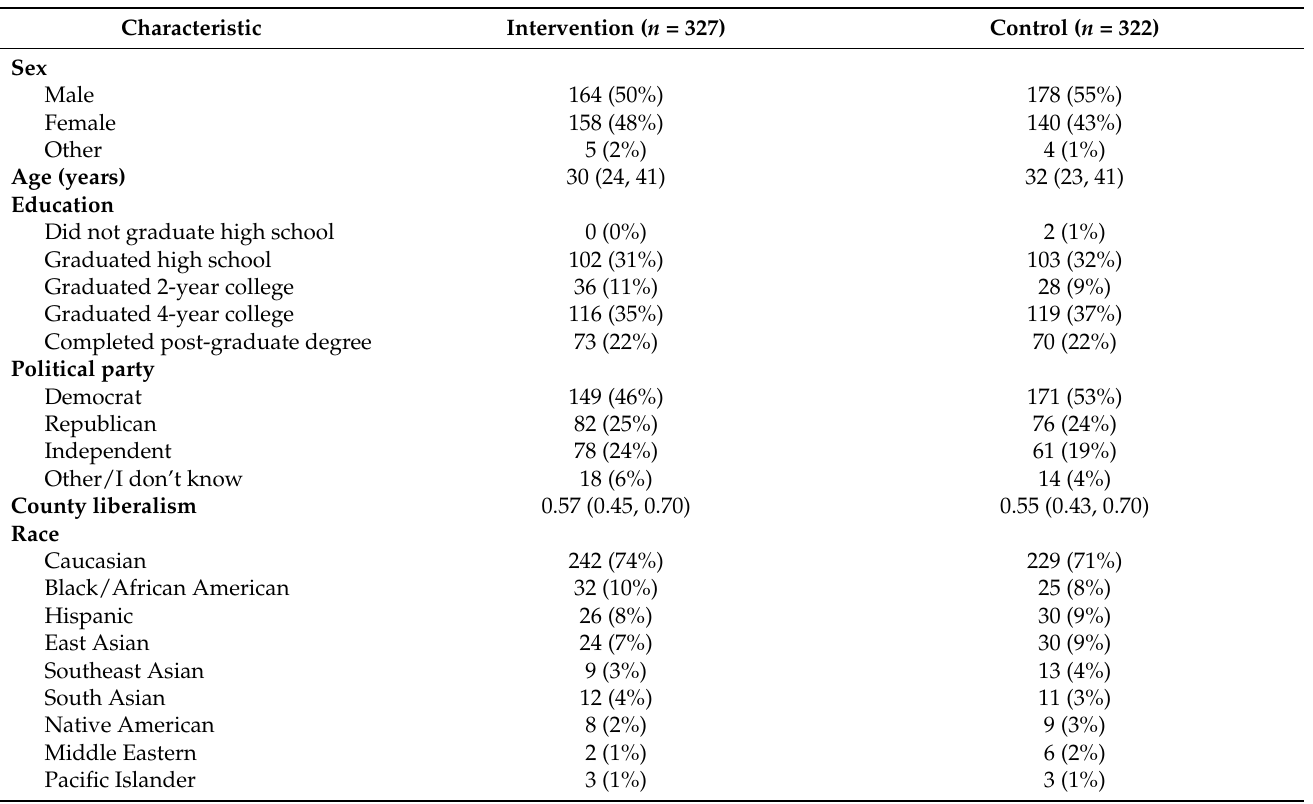
Table 1. For Study 1, demographic characteristics of the 649 participants at baseline. Continuous variables are reported as medians with 25th and 75th percentiles. Binary variables are reported as counts and percentages. Subjects could indicate multiple races. “County liberalism”: in the subject’s county, the proportion of votes from the 2000–2016 United States presidential elections that went to the Democratic